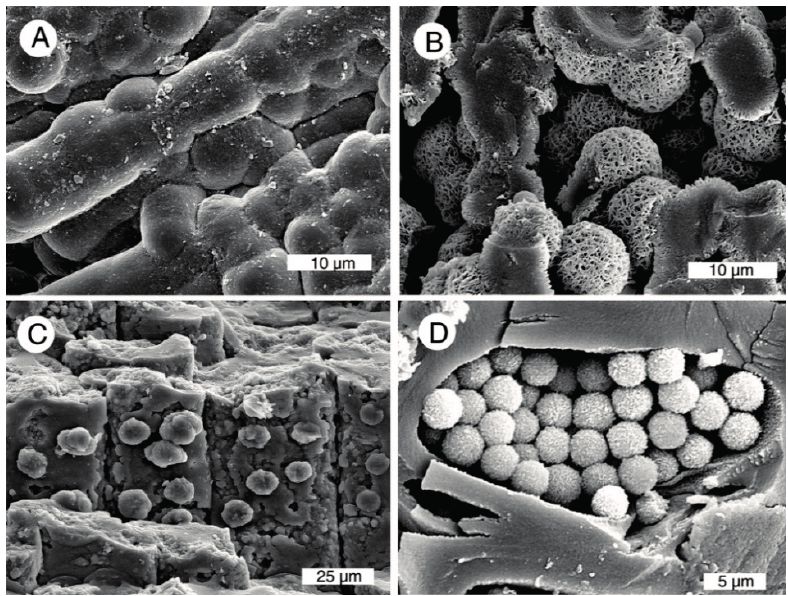
Figure 6. Examples of opal-CT. ( A ) Tracheids coated with microcrystalline opal, location 20; ( B ) Opal-CT lepispheres showing networks of tabular crystals, location 2 (Pandora opal mine); ( C ) Tracheids mineralized with fine-grained opal-CT, showing prominent internal casts of pit apertures. Intercellular spaces are unmineralized, locality 16; ( D ) Crystalline lepispheres of uniform diameter filling a single tracheid with carbonized cell walls, location 2 (Royal Peacock opal